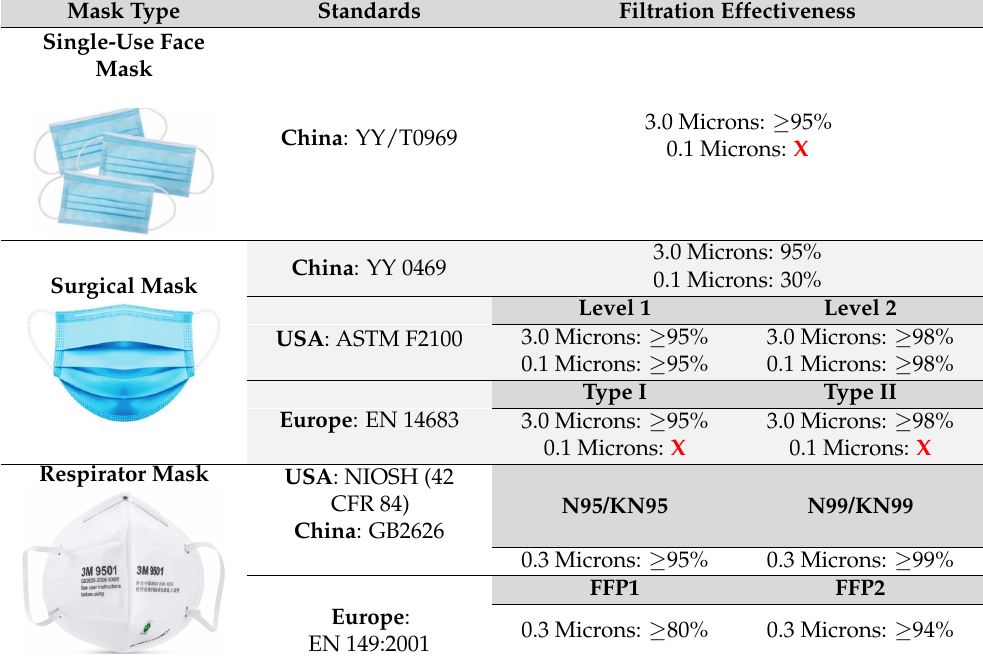
3.0 Microns: Bacteria Filtration Efficiency standard (BFE); 0.1 Microns: Particle Filtration Effi-